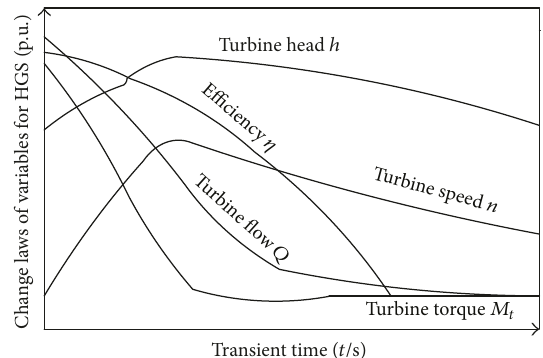
Figure 2: Schematic diagram of the change laws of variables in the nonlinear HGS during the load rejection transient